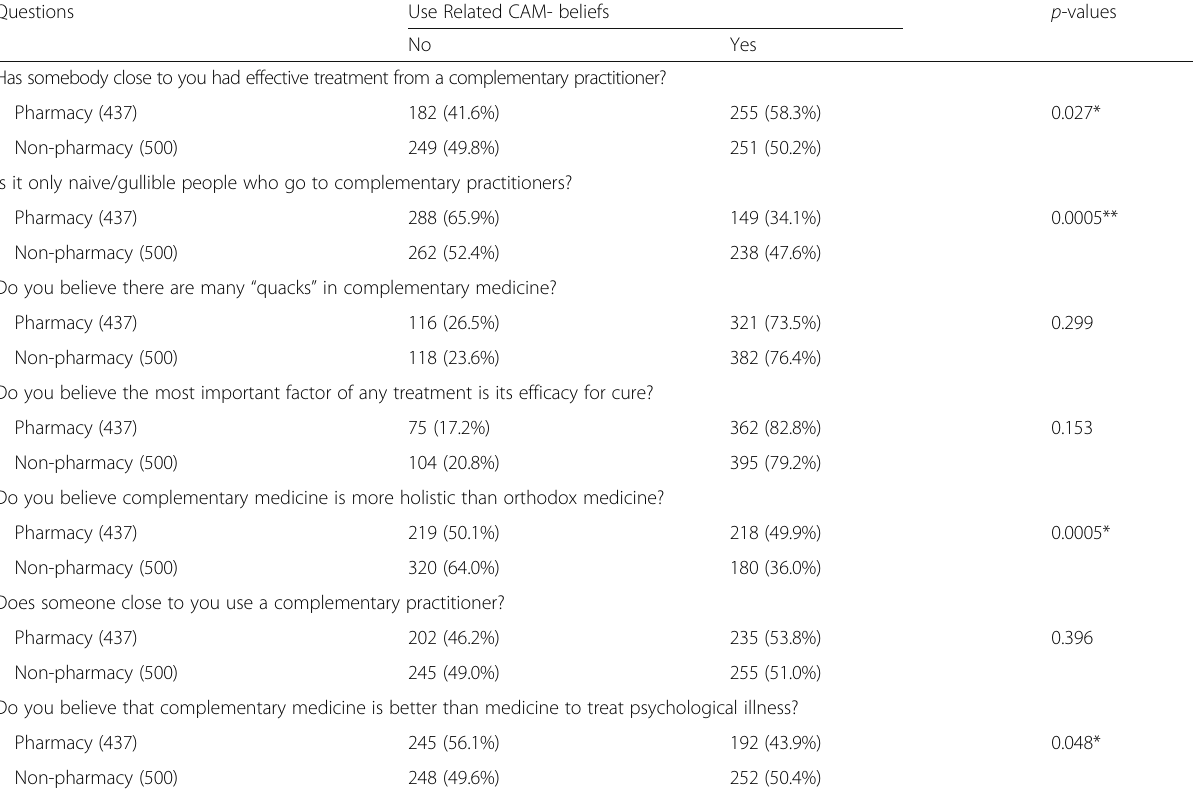
Table 4 Use Related CAM Beliefs Among